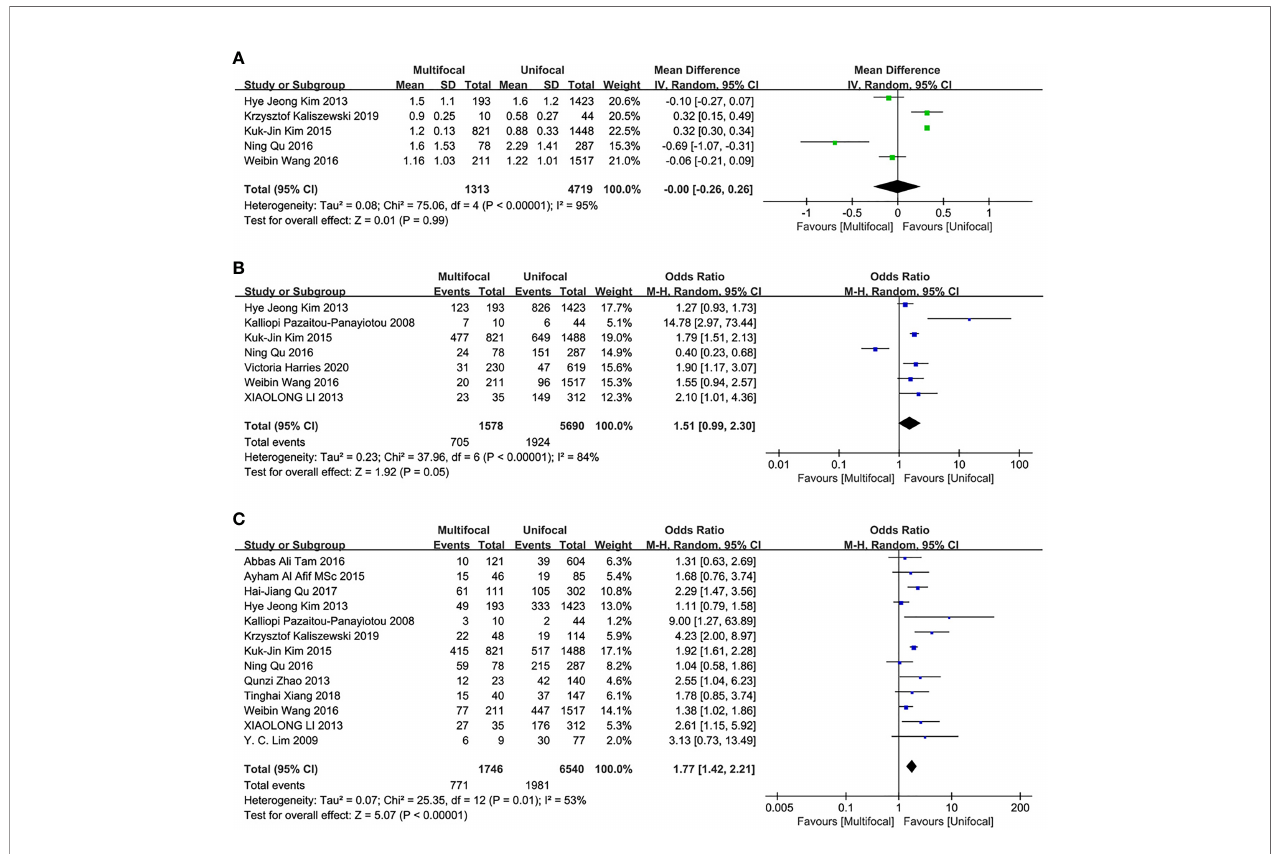
FIGURE 3 | Meta-analysis results for the difference between the UMPTC and UUPTC. (A) Size; (B) ETE; (C)